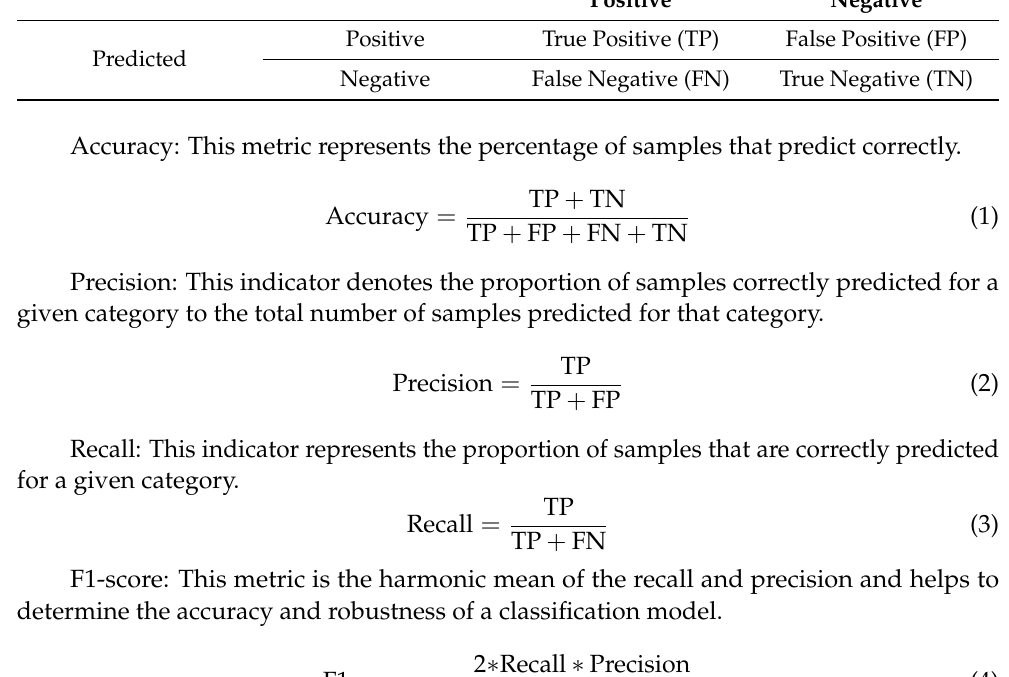
Table 1. Confusion matrix for the binary classification.